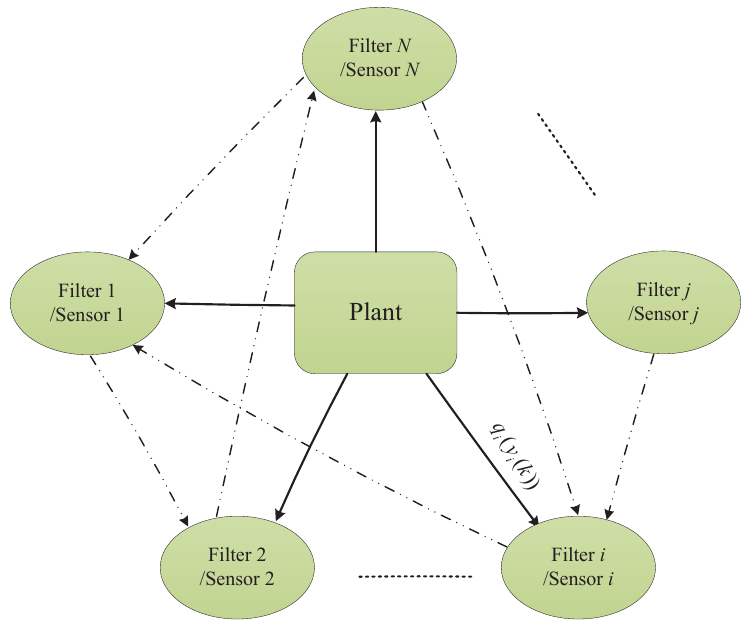
Figure 1. A distributed filtering framework based on